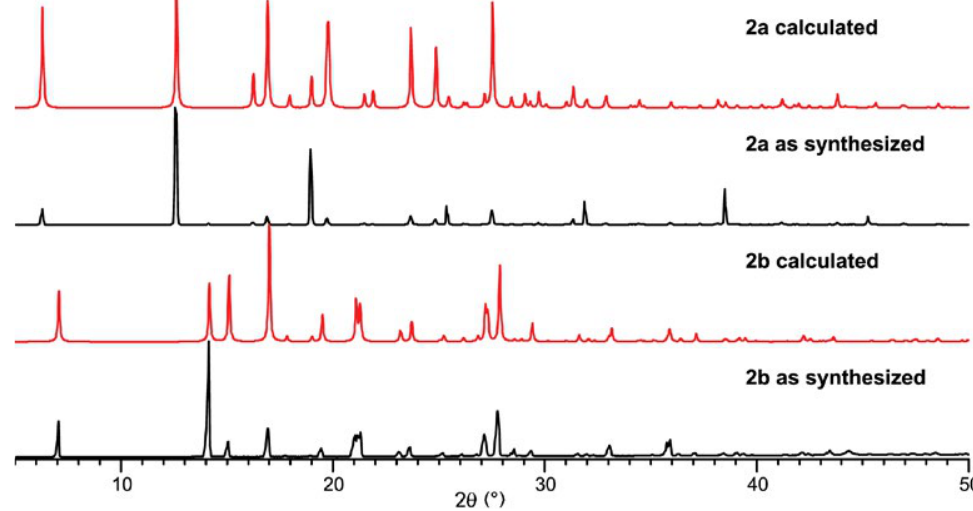
Figure 4. Calculated and experimentally determined PXRD patterns of polymorphs 2a and 2b